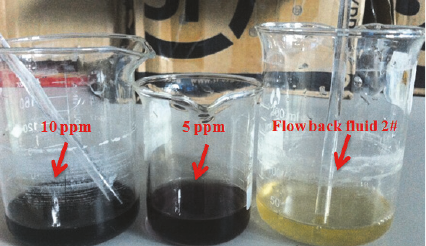
Figure 3: Comparison of flowback fluid Sample 2# with 5 ppm and 10ppm ammonium persulfate control samples after both potassium iodide and starch were added.